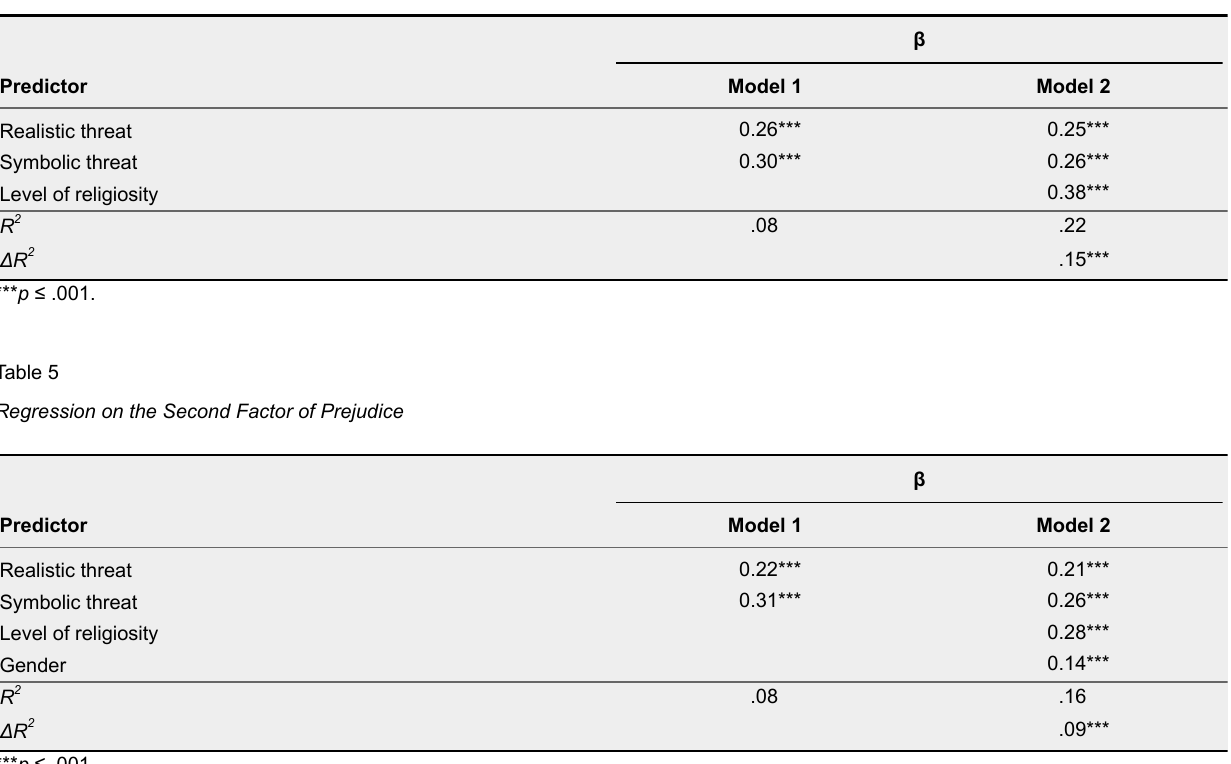
Regression on the First Factor of Prejudice